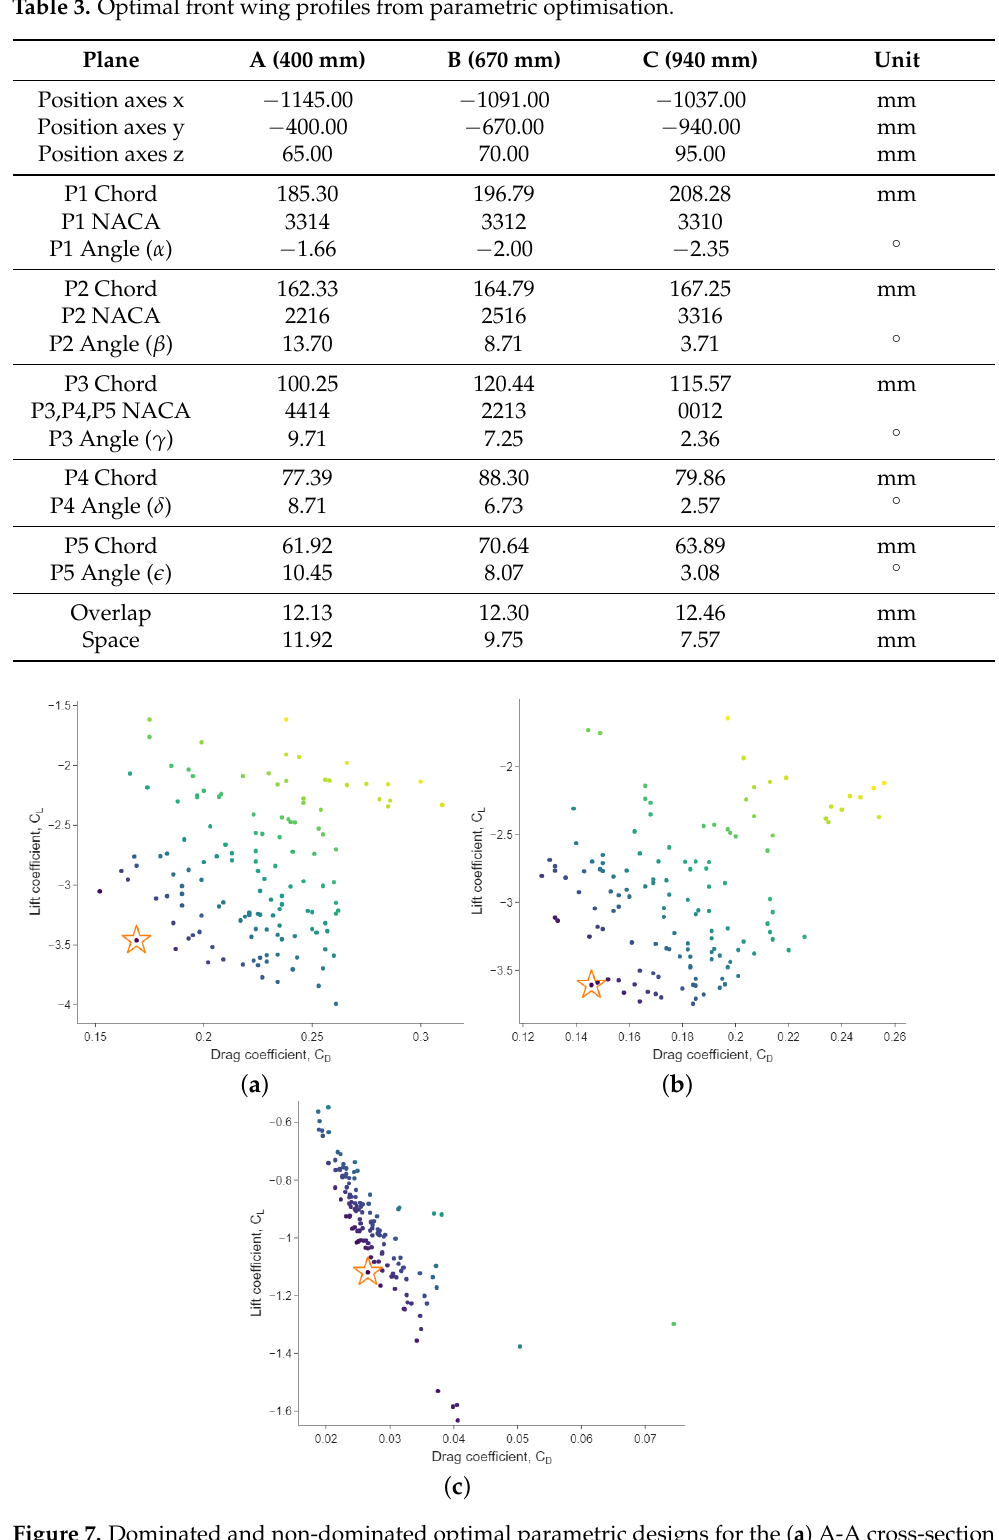
Figure 7. Dominated and non-dominated optimal parametric designs for the ( a ) A-A cross-section (400 mm), ( b ) B-B cross-section (670 mm), and ( c ) C-C cross-section (940 mm), of the five-element front wings from the specified input design variable